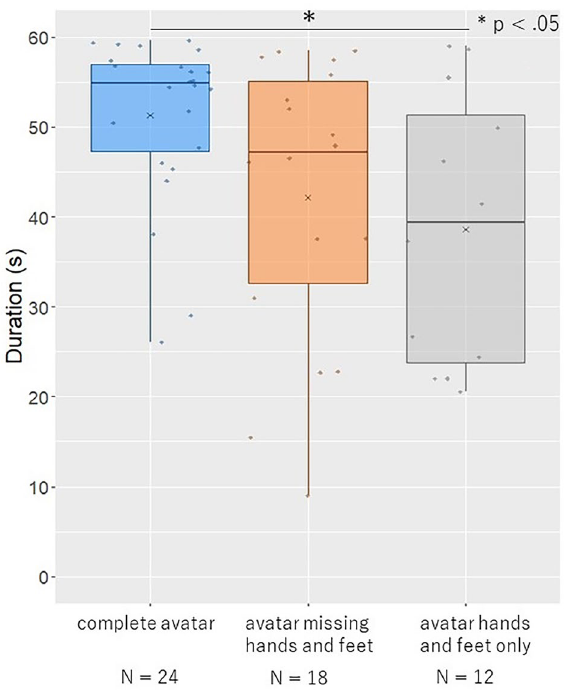
Figure 3. Results of the duration. The horizontal thick lines indicate the medians and “x” indicate the mean values. Individual data points are plotted in